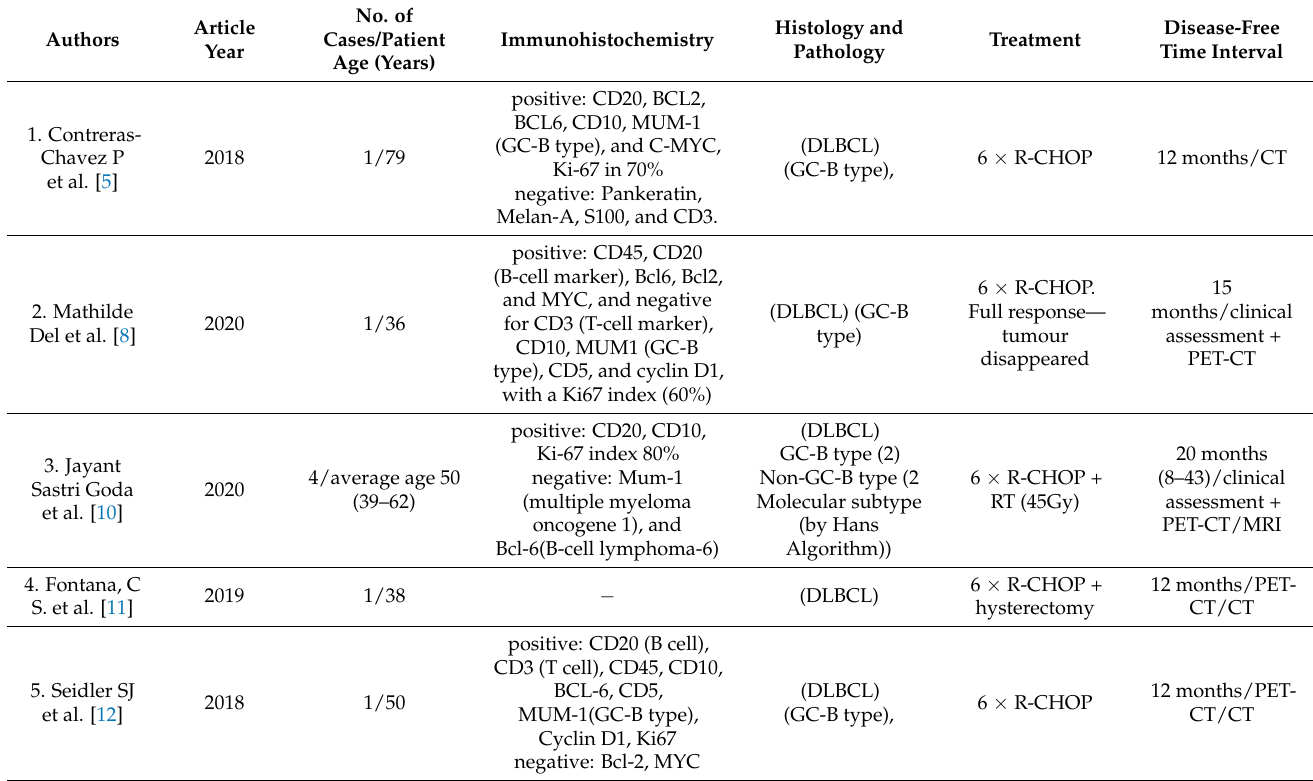
Table 1. Primitive uterine cervix